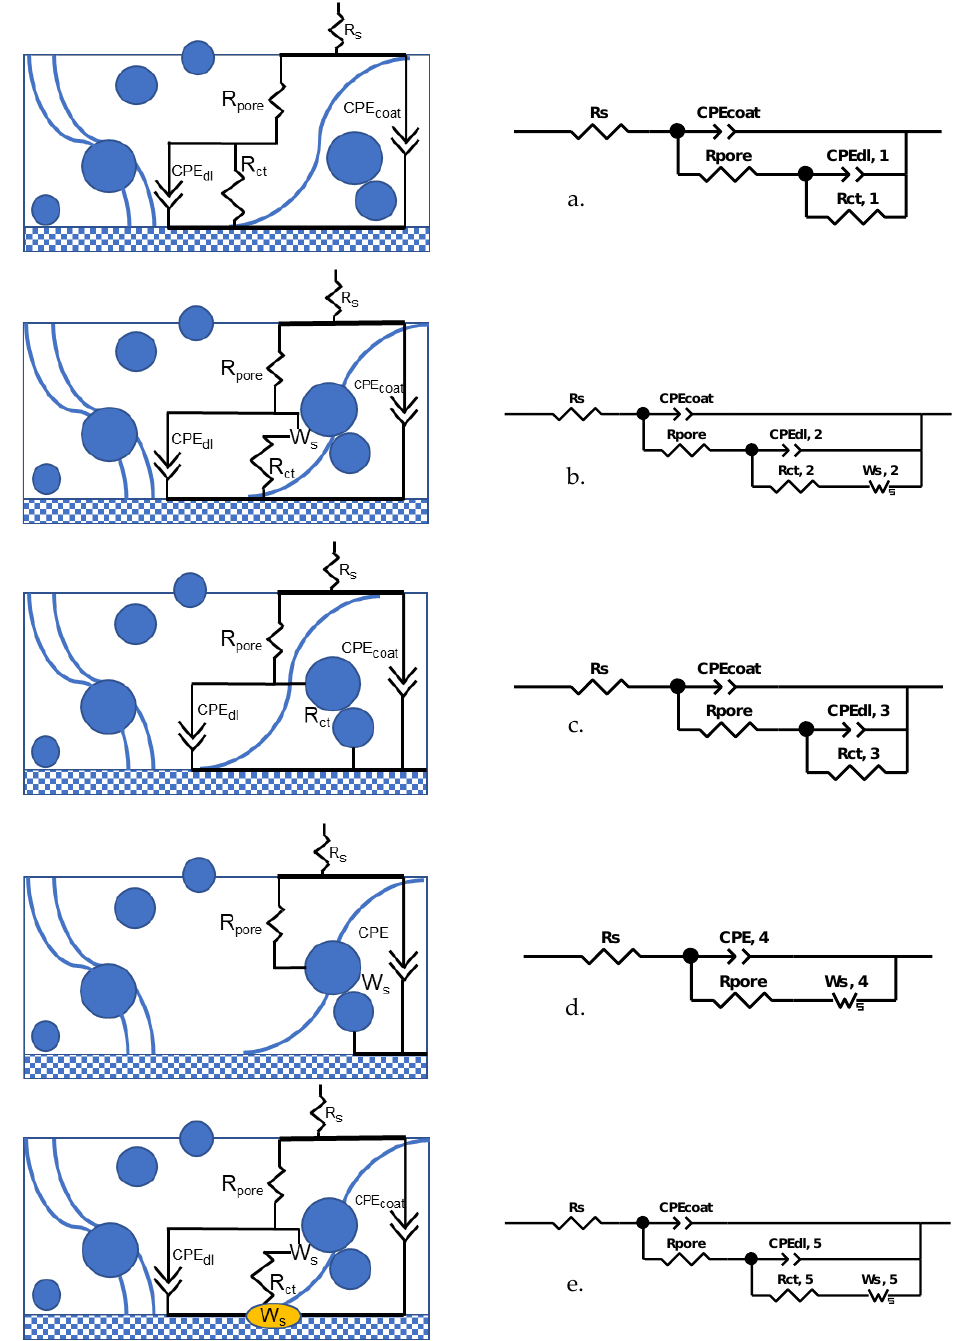
Figure 8. ( a – e ) Schematics and EECs for EIS data fitting for a coating with 80% zinc in PC. ( a ) Stage 1; ( b ) Stage 2; ( c ) Stage 3; ( d ) Stage 4; ( e ) Stage 5.